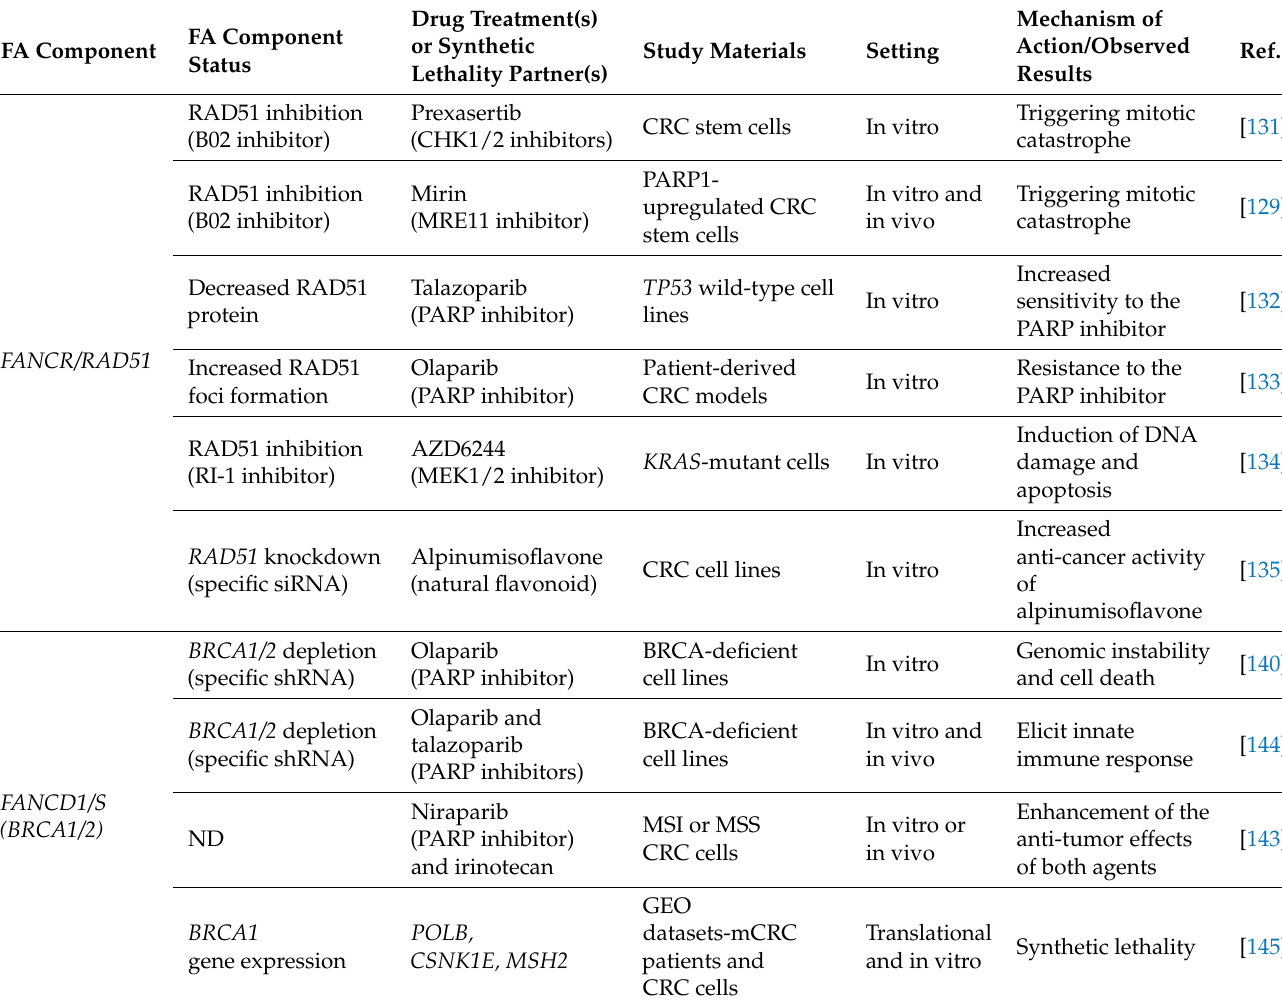
Table 2. FA components as potential therapeutic targets in